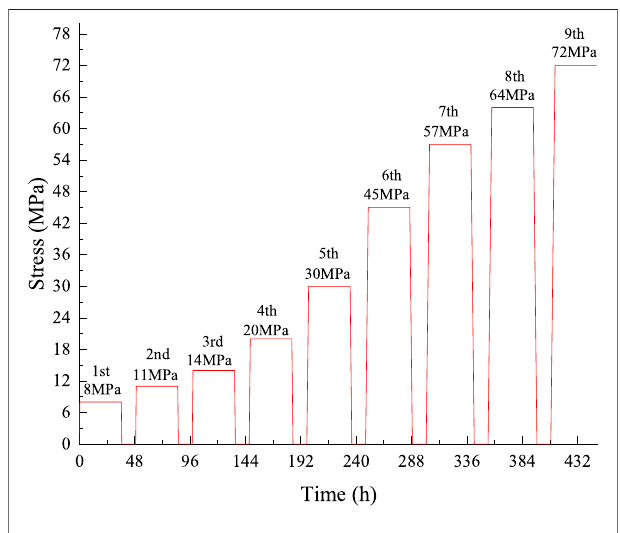
FIGURE 5 | Multilevel loading and unloading cycles used in the creep test.